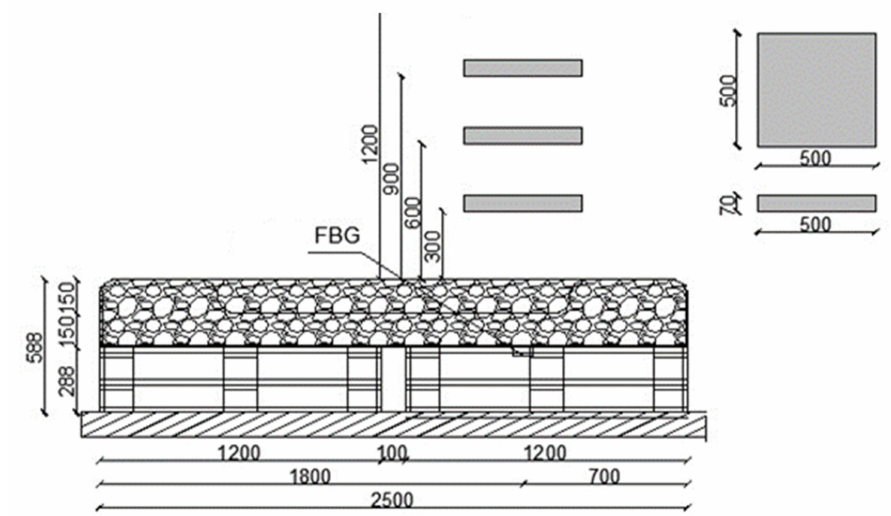
Figure 11. Idea of the testing—Heaviside step function (cm).